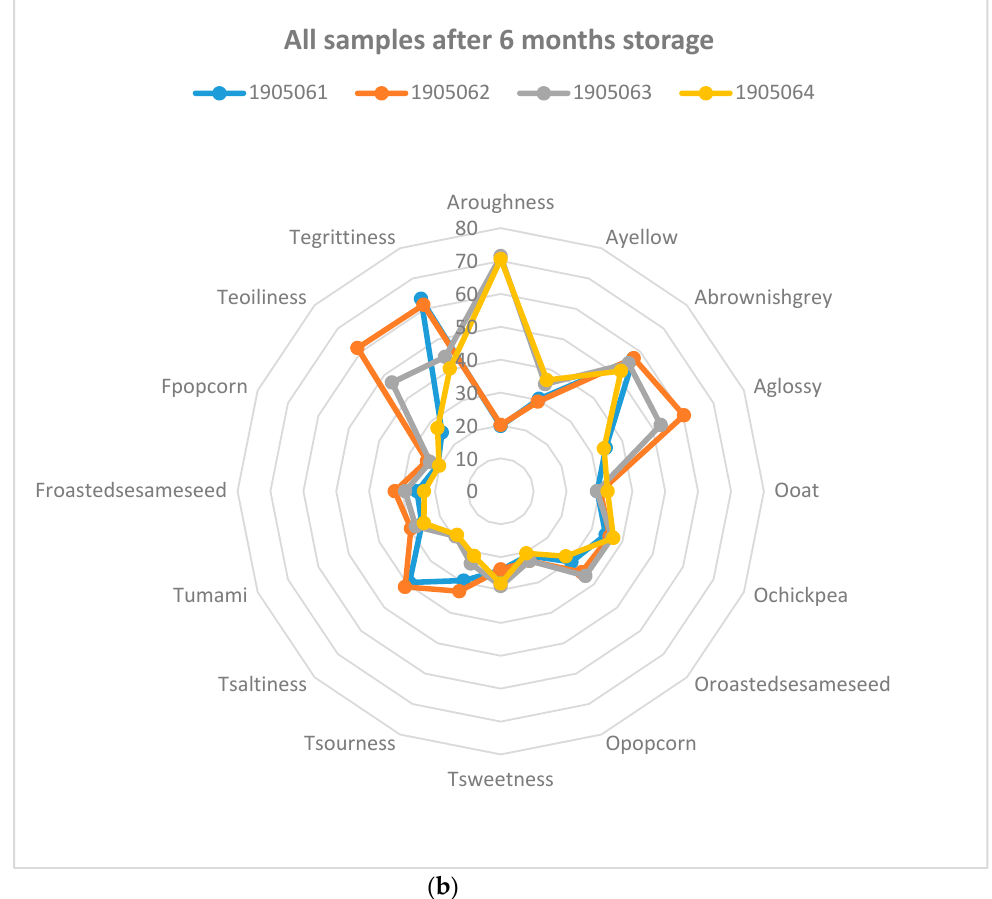
Figure 2. Spider diagram of sensory attributes of ( a ) fresh samples and ( b ) after 6 months of storage.